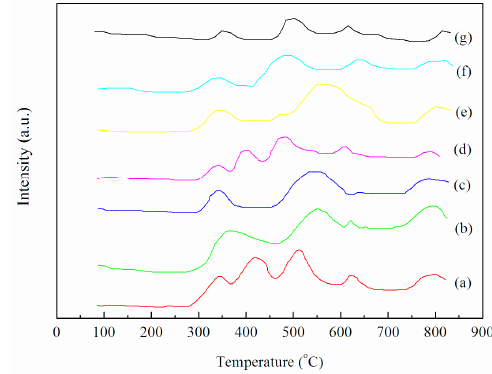
Figure 7. H 2 ‐ TPR of fresh, deactivated, and regenerated catalysts. ( a ) Co ‐ Zn/H ‐ Beta ‐ F, ( b ) Co ‐ Zn/H ‐ Beta ‐ D, ( c ) Co ‐ Zn/H ‐ Beta ‐ R (O 2 , 550 °C), ( d ) Co ‐ Zn/H ‐ Beta ‐ R (H 2 , 550 °C), ( e ) Co ‐ Zn/H ‐ Beta ‐ R (H 2 + O 2 , 450 °C), ( f ) Co ‐ Zn/H ‐ Beta ‐ R (O 2 + H 2 , 450 °C), ( g ) Co ‐ Zn/H ‐ Beta ‐ R (O 2 + H 2 , 550 °C).